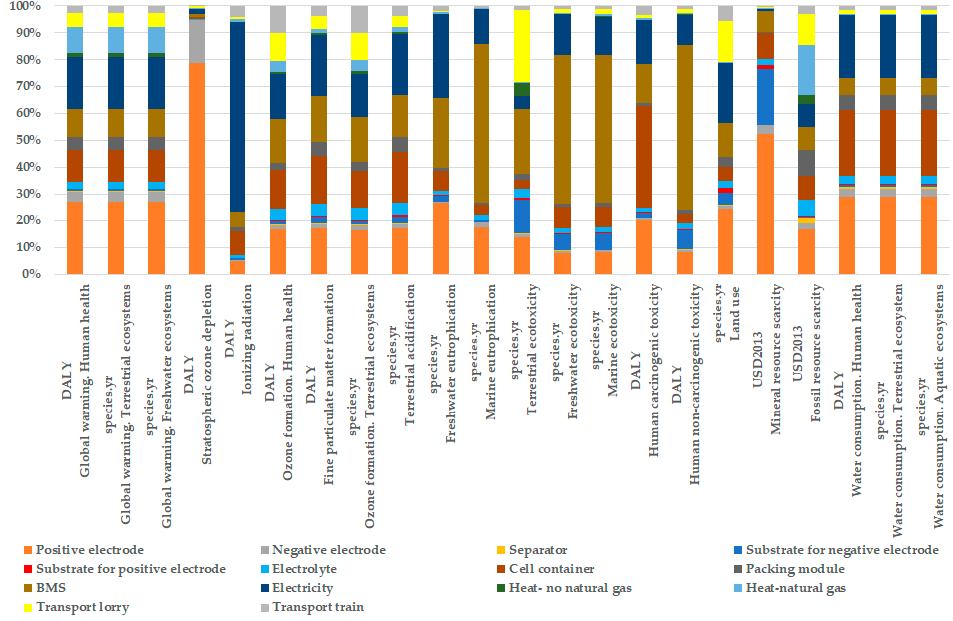
Figure 4. Characterization of the assembly phase for LFP (ReCiPe 2016 method-Endpoint (H)).